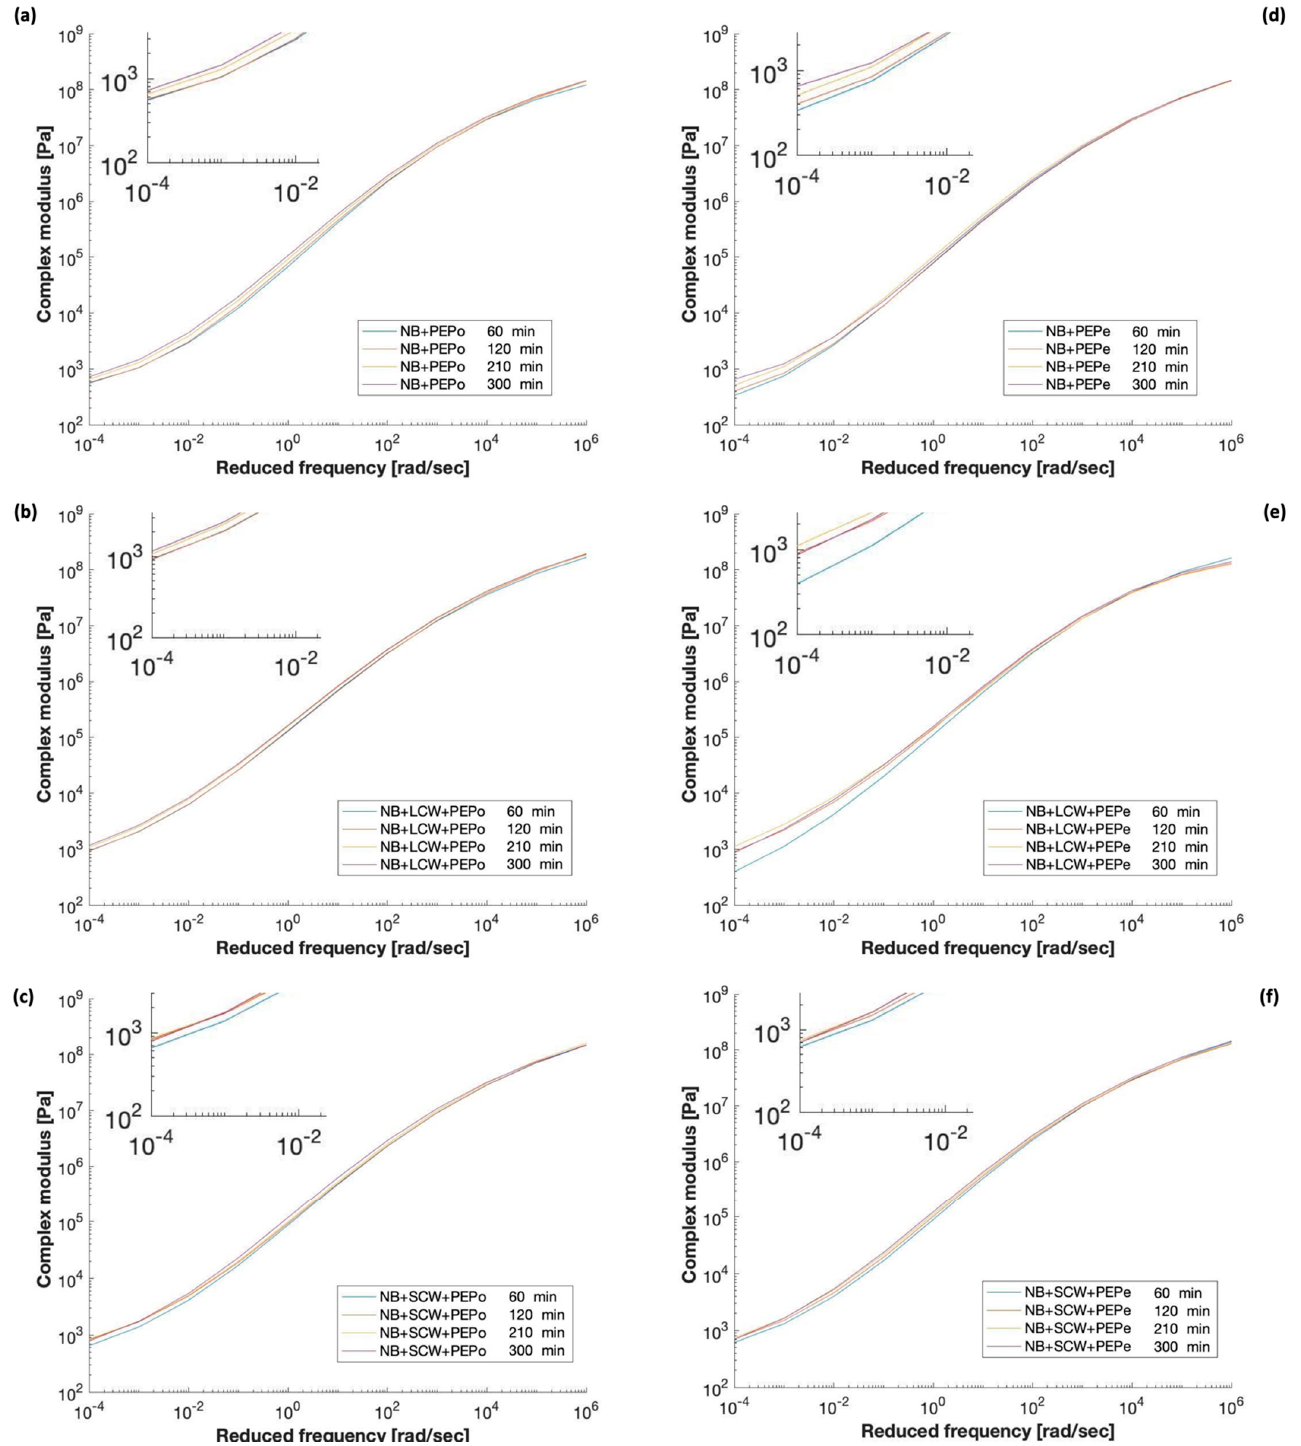
Figure 5. Master curves of ( a ) NB+PEPo, ( b ) NB+PEPo+LCW, ( c ) NB+PEPo+SCW, ( d ) NB+PEPe, ( e ) NB+PEPe+LCW, and ( f ) NB+PEPe+SCW.